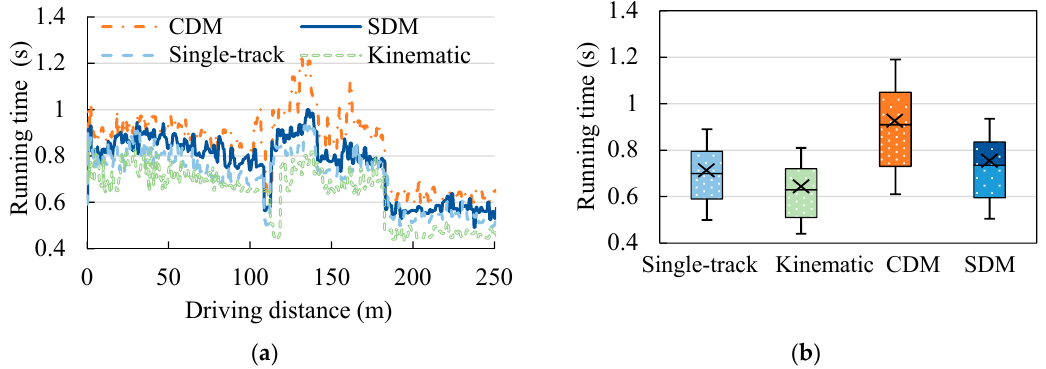
Figure 14. Consumptions of computation resources: ( a ) running time of single cycle; ( b ) statistical results. It is found from Figure 14a that the running time of NMPC-SDM is smaller than NMPC-CDM and larger than NMPC-KM overall. Compared with NMPC-CDM, the aver- age running time of single cycle of NMPC-SDM is reduced from 0.91 s to 0.74 s (See